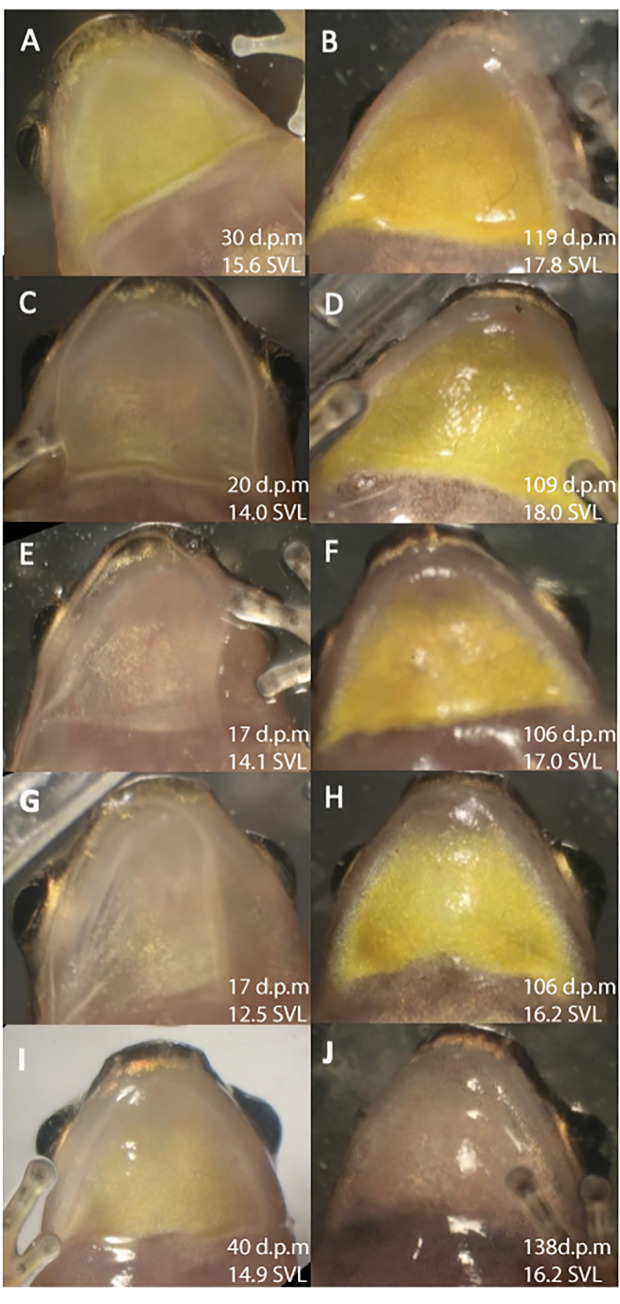
Throat colour patch development in a selection of post-metamorphic M. trinitatis reared in captivity.d.p.m = days post metamorphosis. Early development left hand column; later stages of the same froglets to the right. Early stages show slight or no yellow pigmentation. Later stages all with yellow throats, female, except frog 5 J, male.